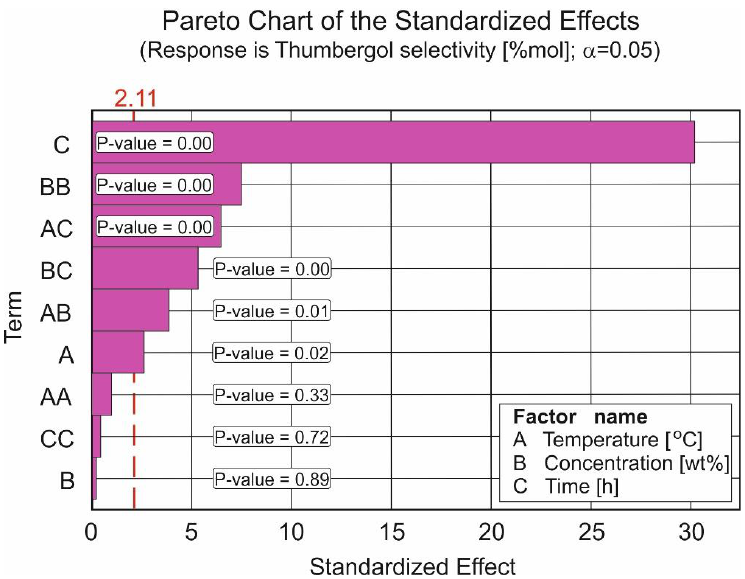
τ is time (h). Figure 6a–i demonstrate the impact of the control factors on the thumbergol selectiv- ity level.